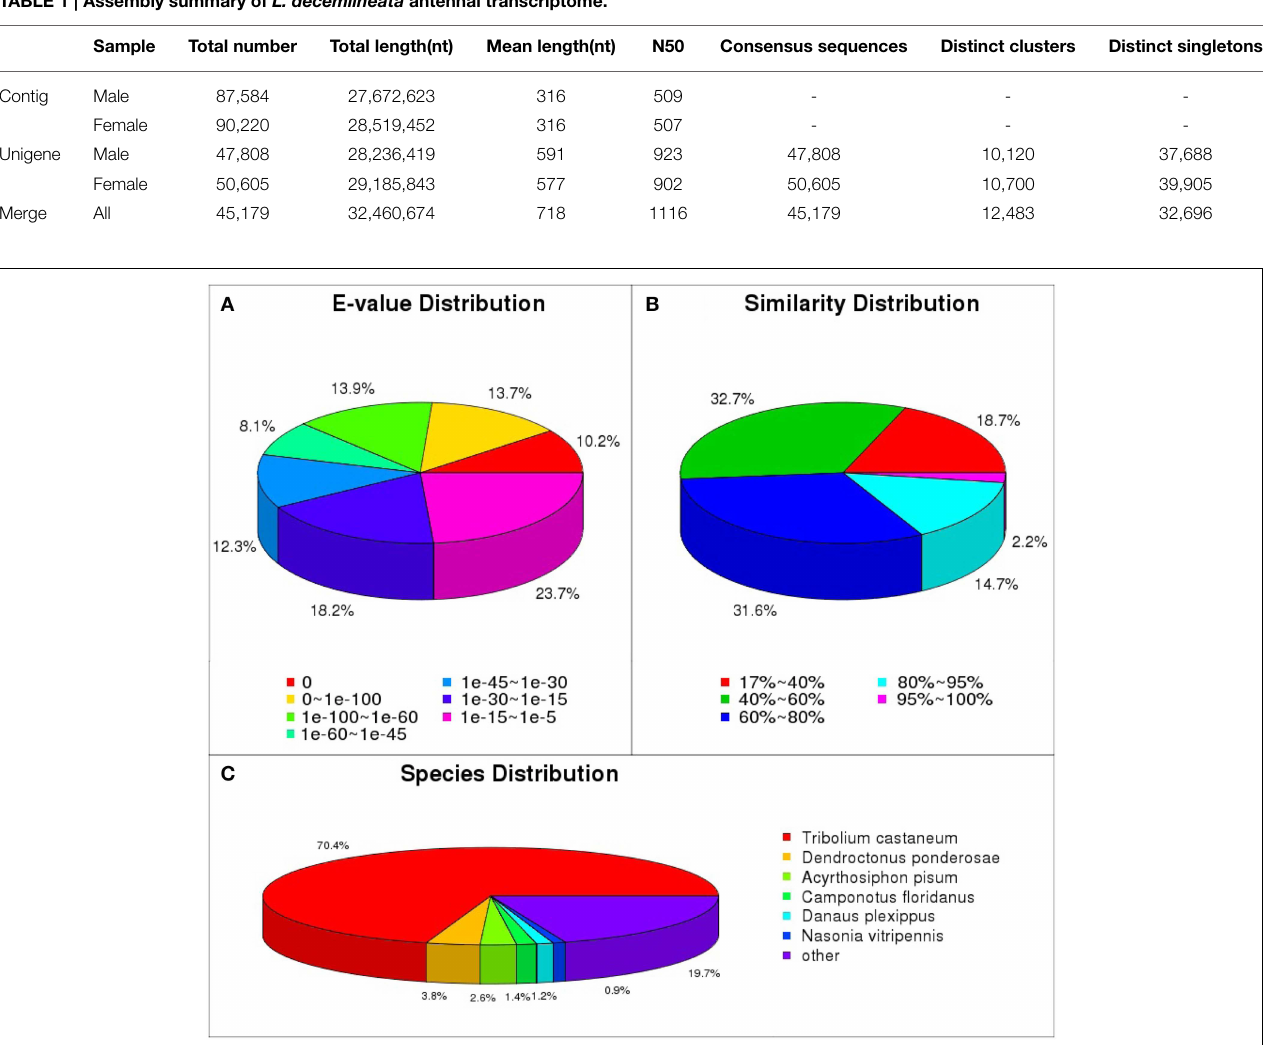
FIGURE 1 | Homology analyses of the L. decemlineata unigenes. All distinct gene sequences (24,880) that had blast annotations against the nr database with a cut-off E -value 10 − 5 were analyzed for (A) E -value distribution, (B) similarity distribution, and (C) species distribution.